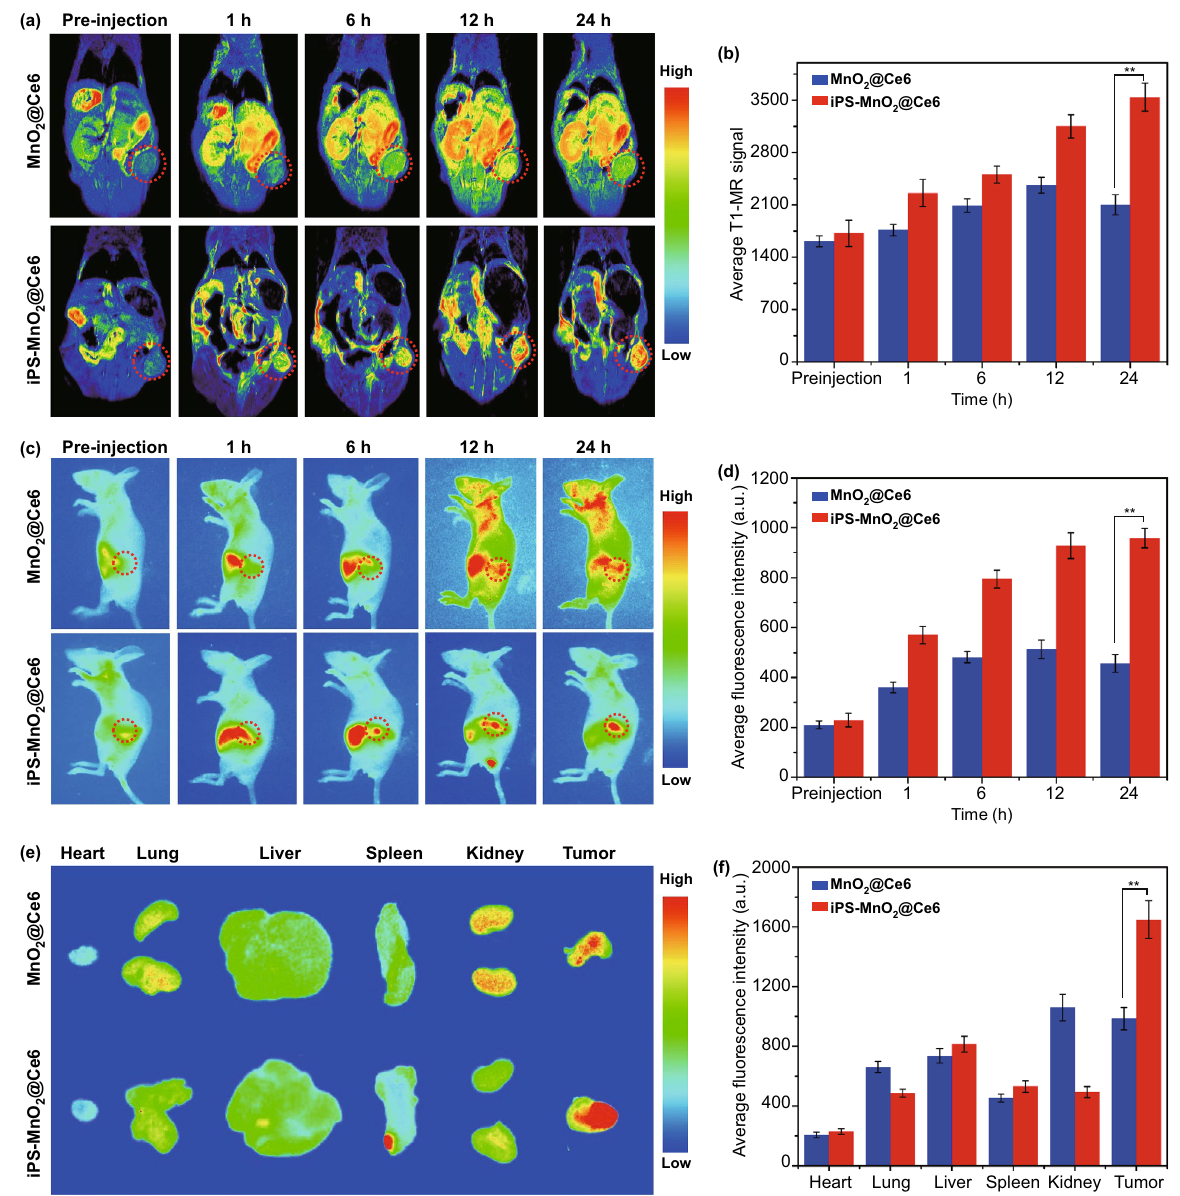
Fig. 4 Distribution and metabolism of iPS-MnO 2 @Ce6 in tumor-bearing mice. a T1-MR images of tumor-bearing mice after the i.v. injection of MnO 2 @Ce6 and iPS-MnO 2 @Ce6 over a period of 24 h. b Quantitative analysis of T1-MR signal from tumor areas in (a). c Real-time fluores- cence images of tumor-bearing mice after the i.v. injection of MnO 2 @Ce6 and iPS-MnO 2 @Ce6. d Quantitative analysis of fluorescence signal from tumor areas in c . e Ex vivo fluorescence images of major organs and tumor tissues. f Quantification of fluorescence signals from images shown in (e). Data were expressed as mean ± SD, ( n = 3, ** P <